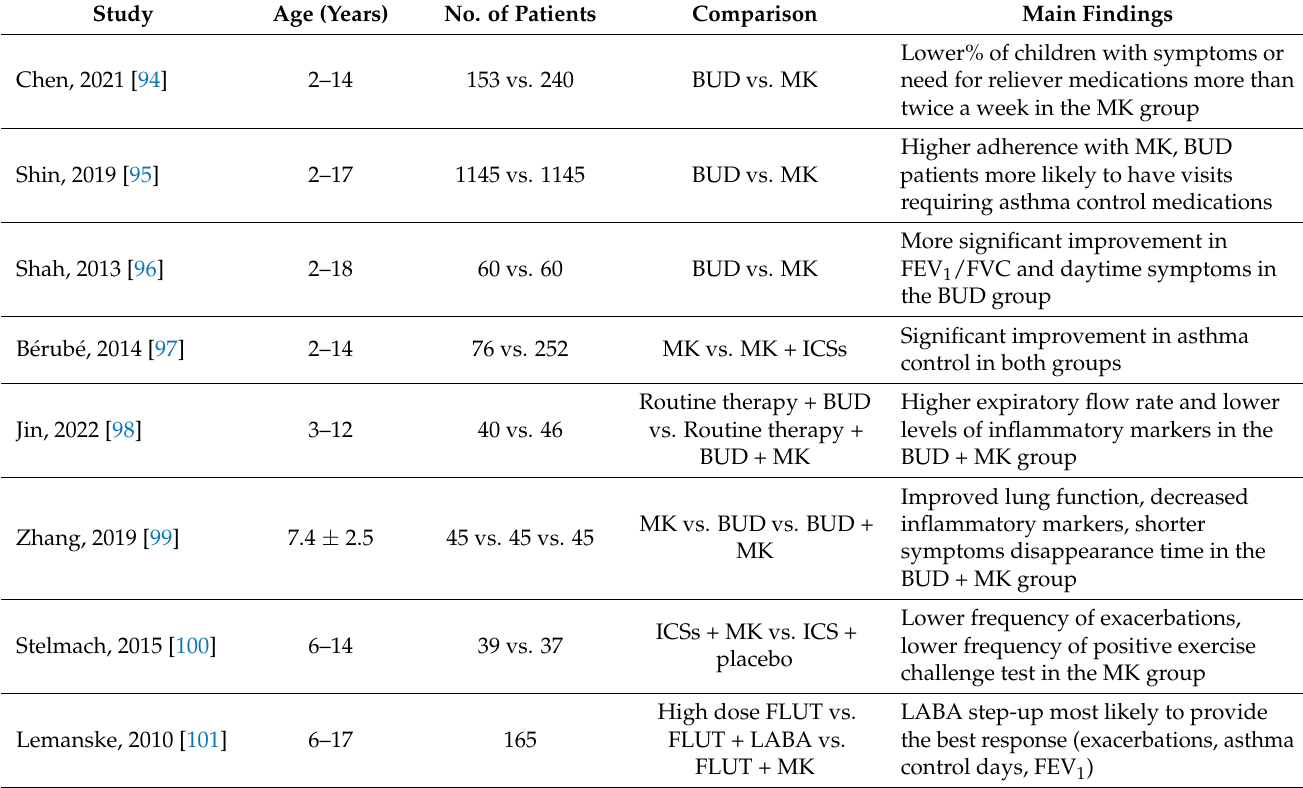
Table 2. Studies published since 2010 comparing montelukast to other controller options in school-age